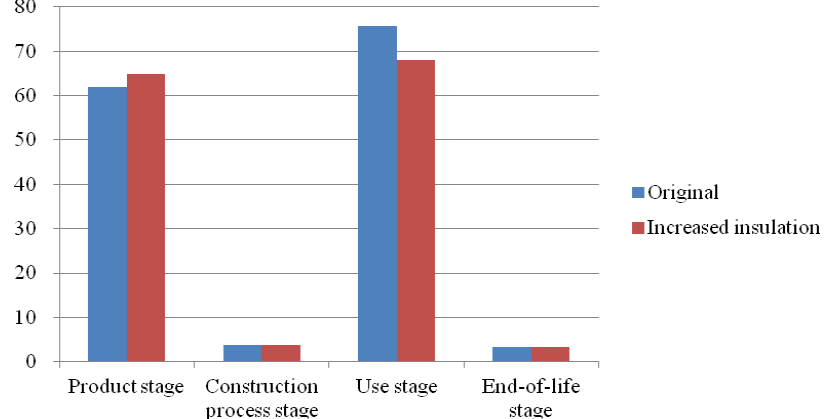
Table 8. Numerical comparison of the cumulative primary energy demand (in kWh-Eq/m 2 year *) in the building analyzed according to the increased insulation improvement. Life cycle stage Original Product stage 64.88 Construction process stage 3.83 Use stage 75.71 68.06 End-of-life stage 3.40 3.40 Figure 5. Graphical comparison of the cumulative primary energy demand (in kWh-Eq/m 2 year *) in the building analyzed according to the increased insulation